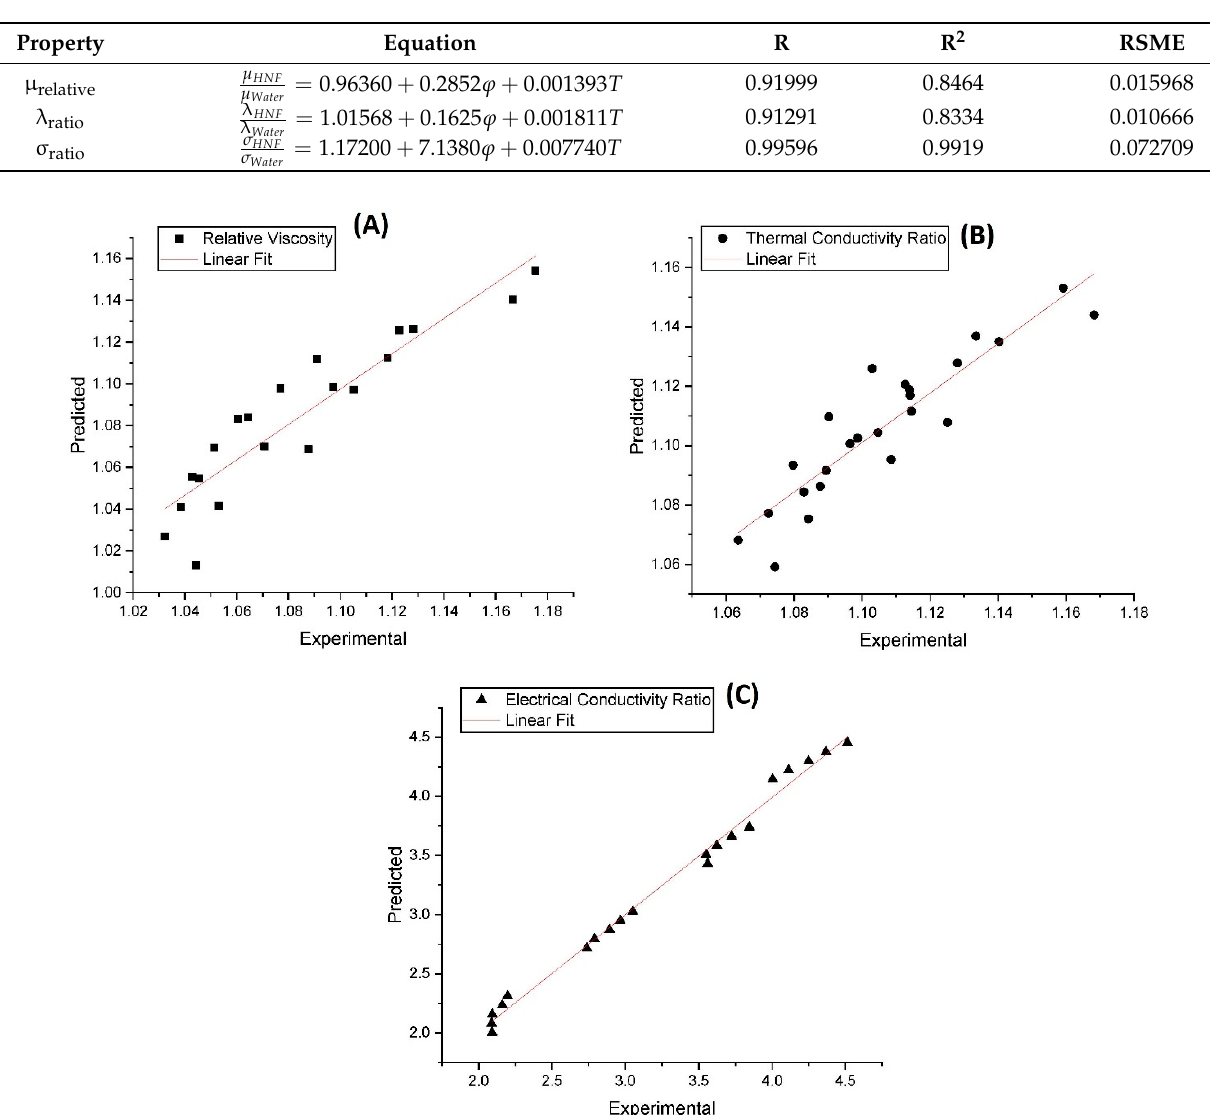
Table 1. Correlation equation for the thermophysical properties of the GNP-Fe 2 O 3 hybrid nanofluid.